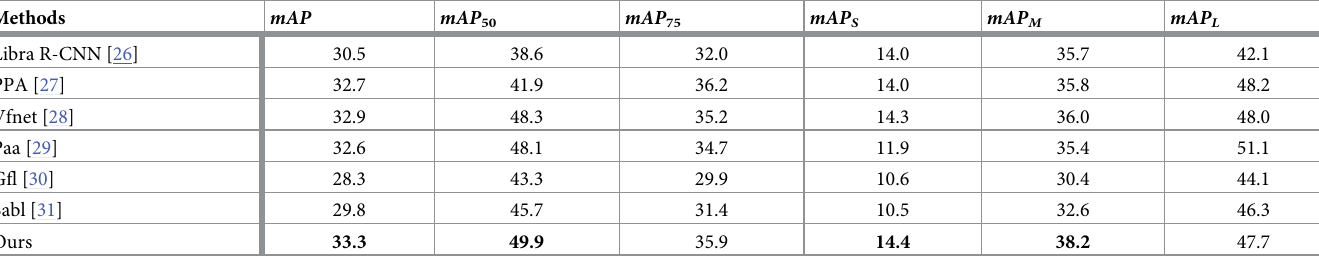
Table 2. Experimental results of different methods on the foggy “CoCo” data set. Methods